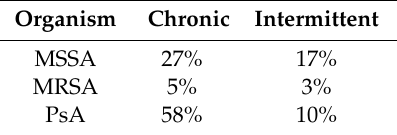
Table 1. Colonisation rates for methicillin-sensitive Staphylococcus aureus (MSSA), methicillin-resistant